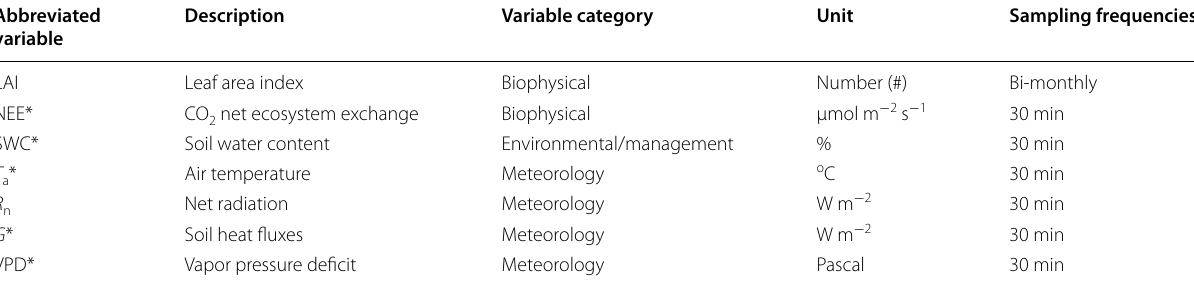
Table 1 Abbreviation and description of the predictor variables used in the machine learning algorithm of the study